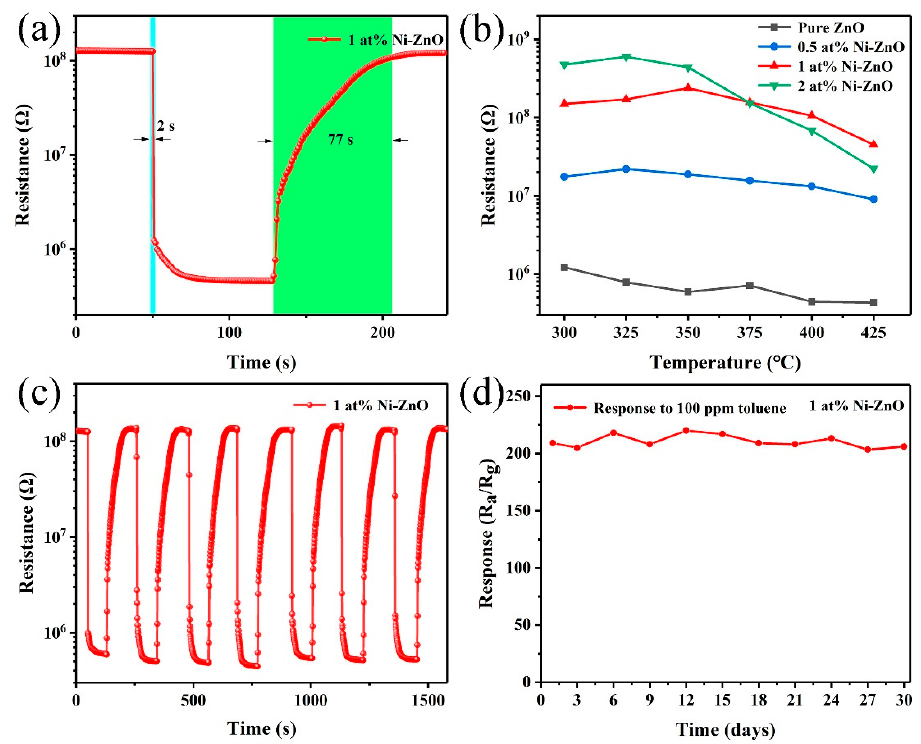
Figure 9. ( a ) The response/recovery time of 1 at% Ni–ZnO gas sensor to 100 ppm toluene at 325 °C. ( b ) Resistance in the air of the four gas sensors at different operating temperatures. ( c ) Seven reversible cycles of 1 at% Ni–ZnO gas sensors. ( d ) The stability testing curves of 1 at% Ni–ZnO gas sensor to 100 ppm toluene in 30 days. Table 2. A comparison of the toluene gas sensing performance of this work and other sensing material in previously reported